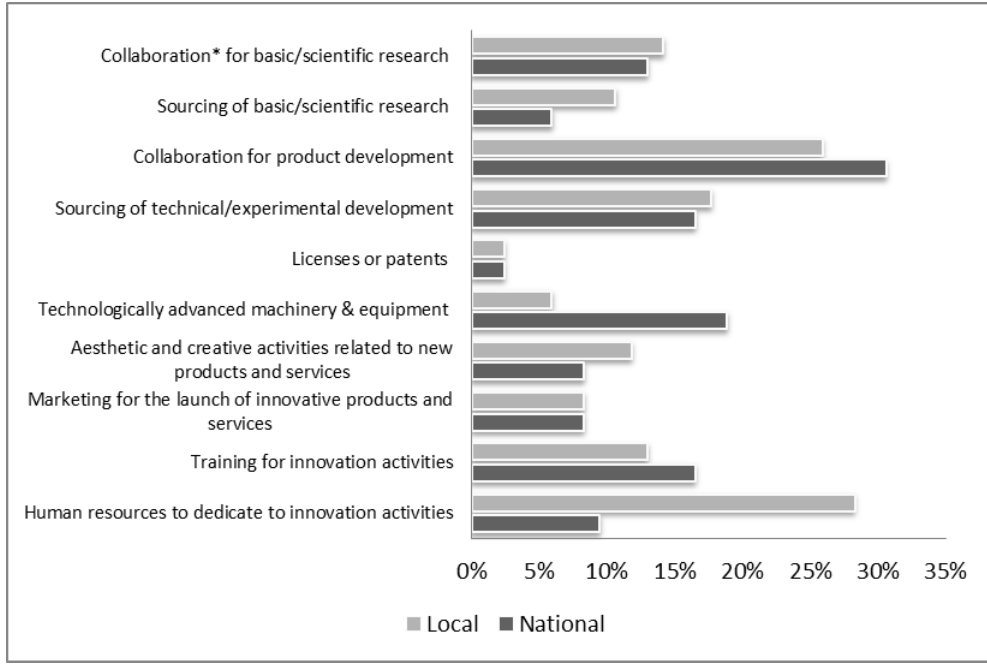
Figure 1: Local and National Distribution of Knowledge and Know-how (Year: 2014-2016, n=85, % of